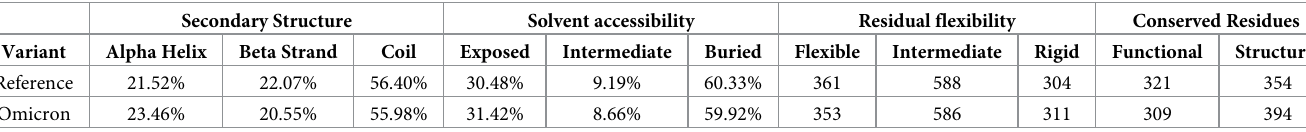
Table 2. Differences in structural features between reference and Omicron variant spike